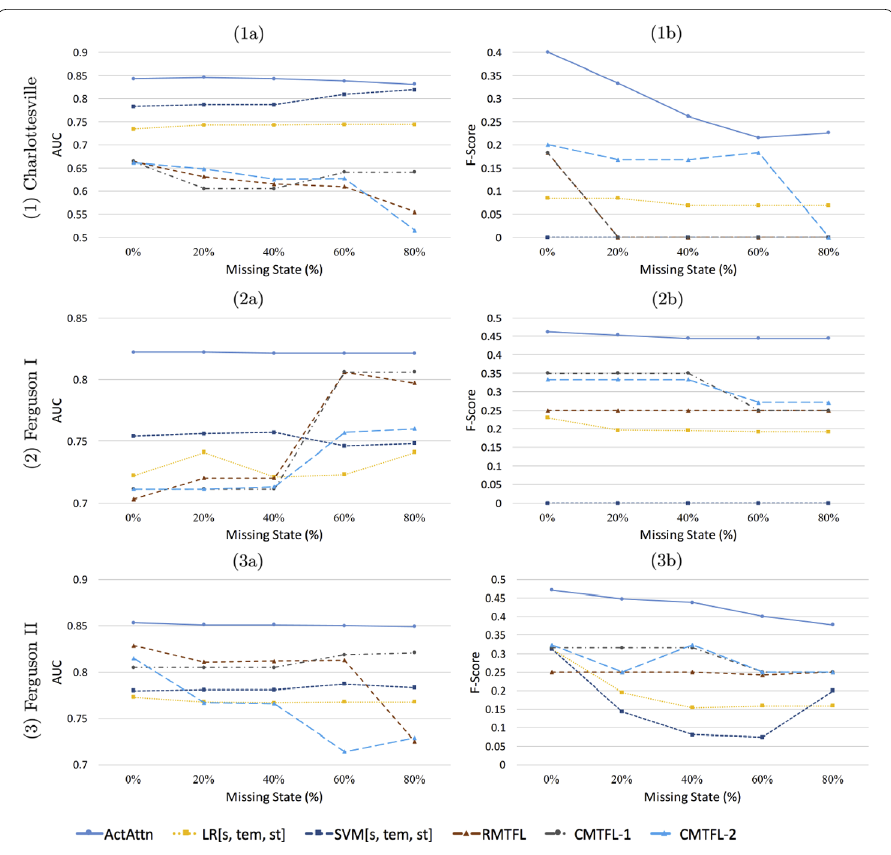
Figure 4 Forecasting results against varying levels of missingness for regions (states) from the test sets. The x -axes indicate the levels of missingness, and the y -axes indicate the performance in terms of ( a ) AUC and ( b ) F-score